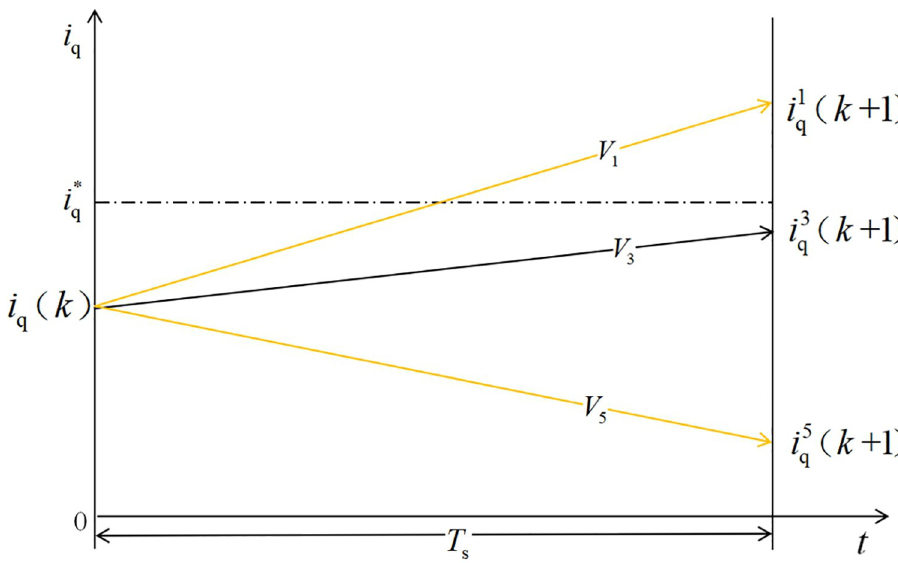
Fig 3. Selection of the first voltage